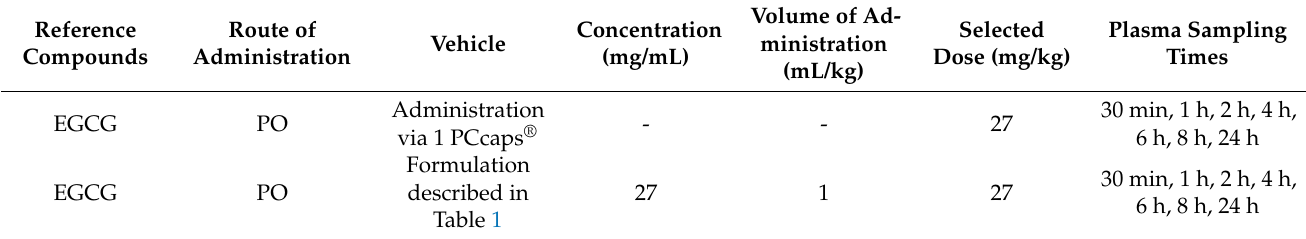
Table 4. Conditions of the bioavailability